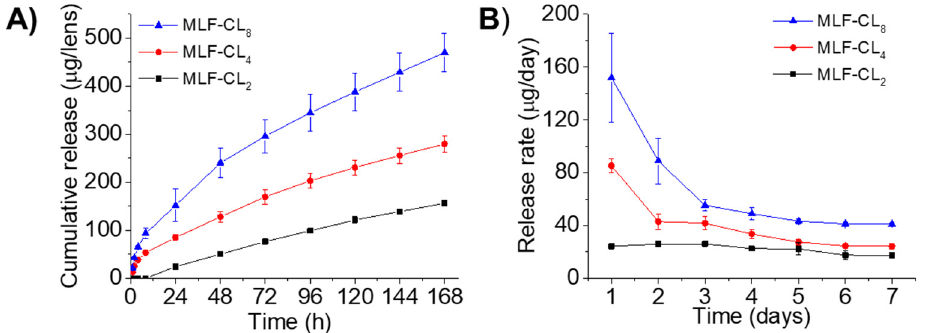
Figure 2. In vitro miltefosine (MLF) release from MLF-CLs. ( A ) the cumulative release and ( B ) the daily release rate. Quantitative data are expressed as mean ± standard deviation (SD), n = 4/group per time point.